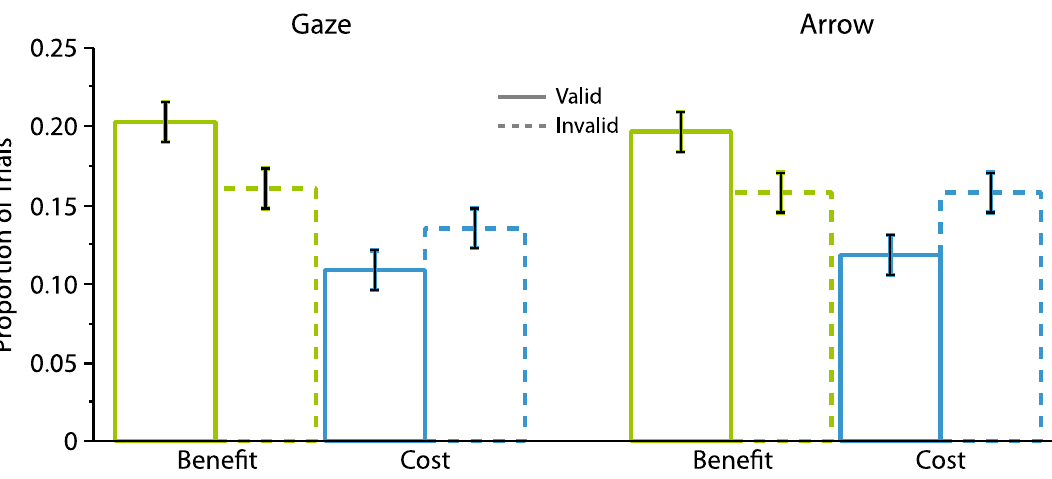
Figure 4. The proportion of benefits and costs as a function of cue type and cue validity for Experiment 1. Error bars represent standard error of the difference between the means.